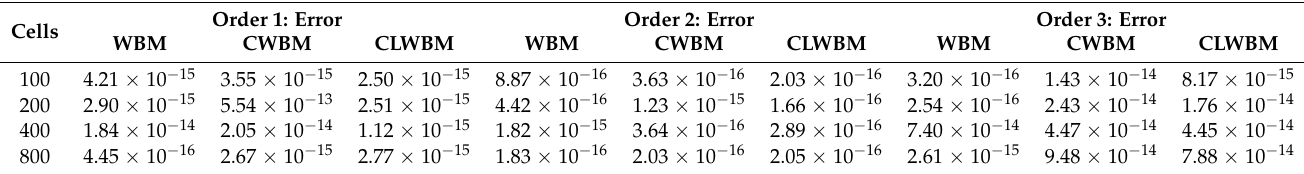
Table 3. Test 1.1. Differences in L 1 -norm with respect to the stationary solution for WBM i , CWBM i , CLWBM i , i = 1,2,3.